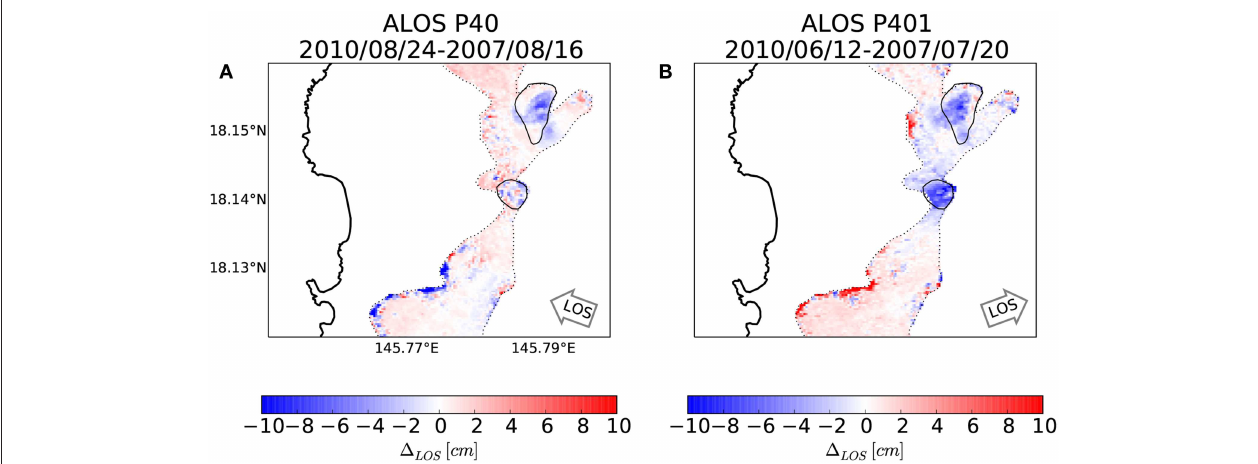
FIGURE 10 | ALOS interferograms showing subsidence of scoria deposits. (A) up to 9 cm of subsidence on north flank. (B) 9 cm of subsidence on north flank, and similar magnitude subsidence seen in summit vent, but is not observed in other interferograms and viewing geometries. Thick black line indicates coastline of Pagan Island. Thin solid black line are extents of scoria deposits from Trusdell et al. (2006). Dotted line corresponds to extents of main flows from 1981 eruption, which is used to crop the interferogram in order to exclude decorrelated vegetated